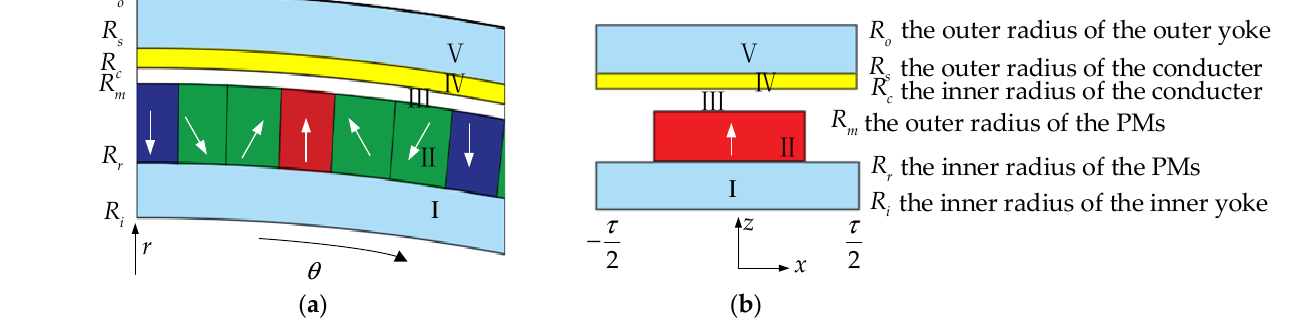
Figure 2. Cutaways of an ECC along the ( a ) circumferential and ( b ) axial direction. The dimensions of a 300 kW cylinder-shaped ECC are R i = 309 mm, R r = 324 mm, R m = 350 mm, R c = 356 mm, R s = 362 mm, R o = 380 mm, τα r = 60 mm, τ = 100 mm, h = 100 mm, and l = 85 mm.